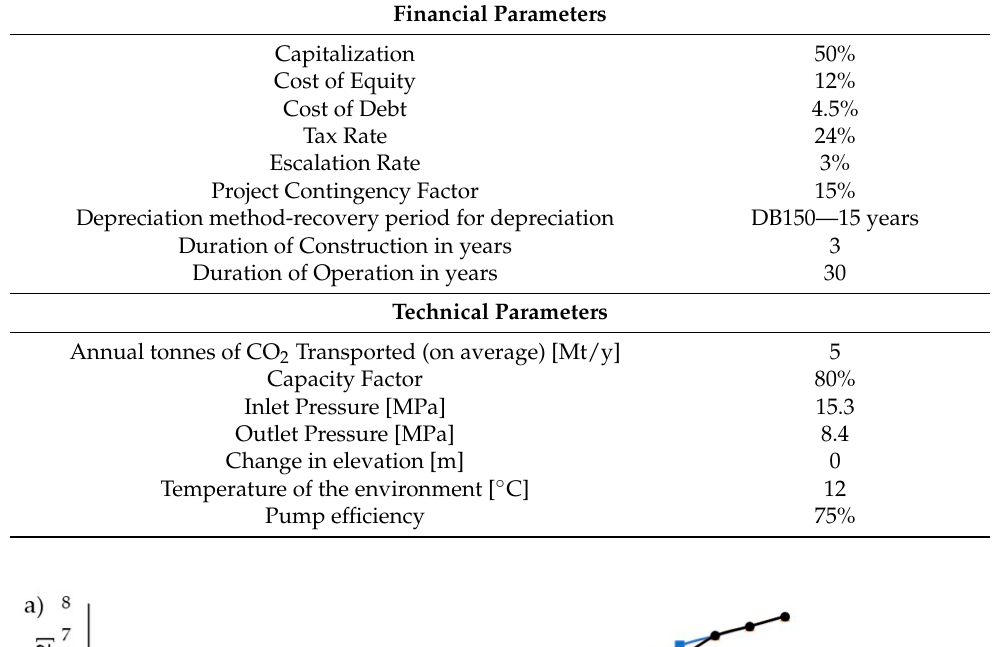
Table 5. Financial parameters and technical parameters used to perform an economic analysis of CO 2 transportation.